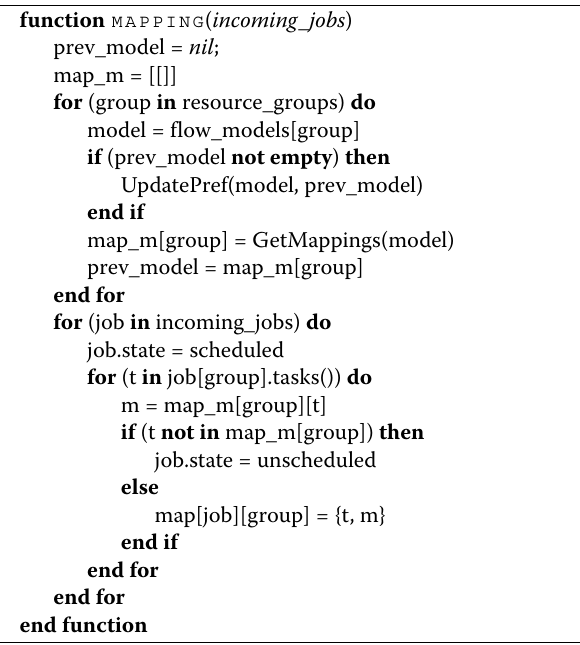
Algorithm 2 DRMaestro Flow-Network